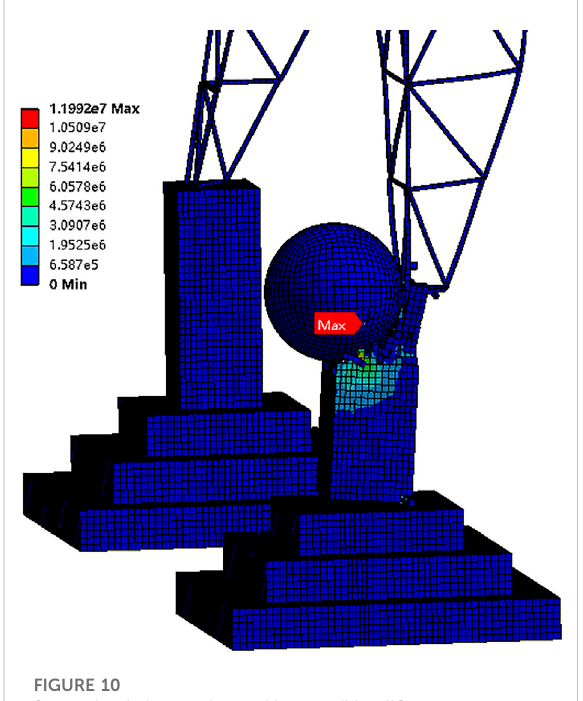
FIGURE 10 Stress cloud chart under working condition II6.